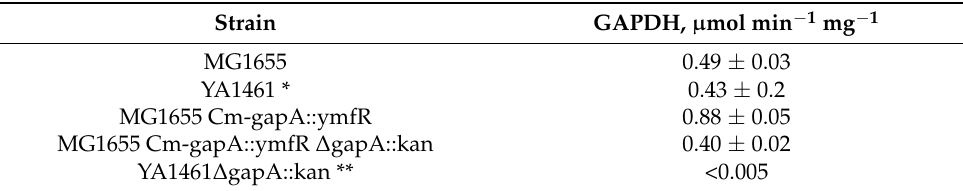
Table 3. NAD + -dependent GAPDH activity in E. coli strains.